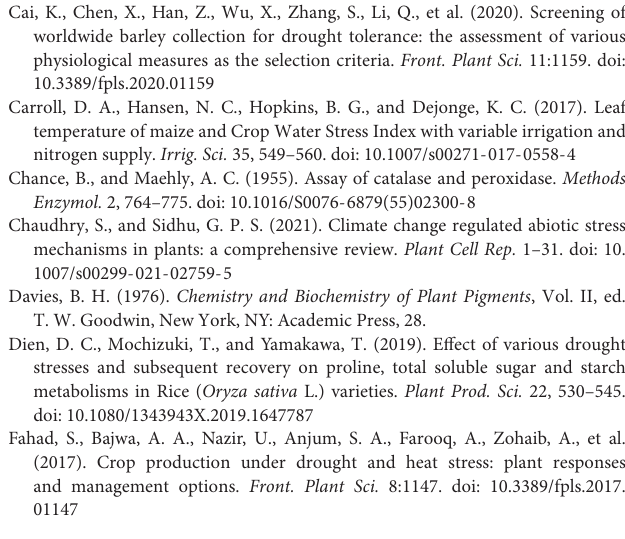
Supplementary Figure 1 | Initial screening of rice genotypes under net house conditions. (A) Control-well irrigated rice plants till 30 days after transplantation (DAT). (B) Stressed-water stress rice plants (water withholding for 15 days after 30 DAT) under net house conditions. (C) Control-well irrigated five rice genotypes viz, IR-55419-04, NIBGE-DT-02, SB, NIBGE-DT-11, and KSK-133 selected from initial screening. (D) Stressed-water stress five rice genotypes viz, IR-55419-04, NIBGE-DT-02, SB, NIBGE-DT-11, and KSK-133. (E) Control-leaves of plants of genotypes IR-55419-04, NIBGE-DT-02, SB, NIBGE-DT-11, and KSK-133, respectively, under well water conditions. (F) Stressed- leaves of plants of genotypes IR-55419-04, NIBGE-DT-02, SB, NIBGE-DT-11 and KSK-133, respectively, under water deficit